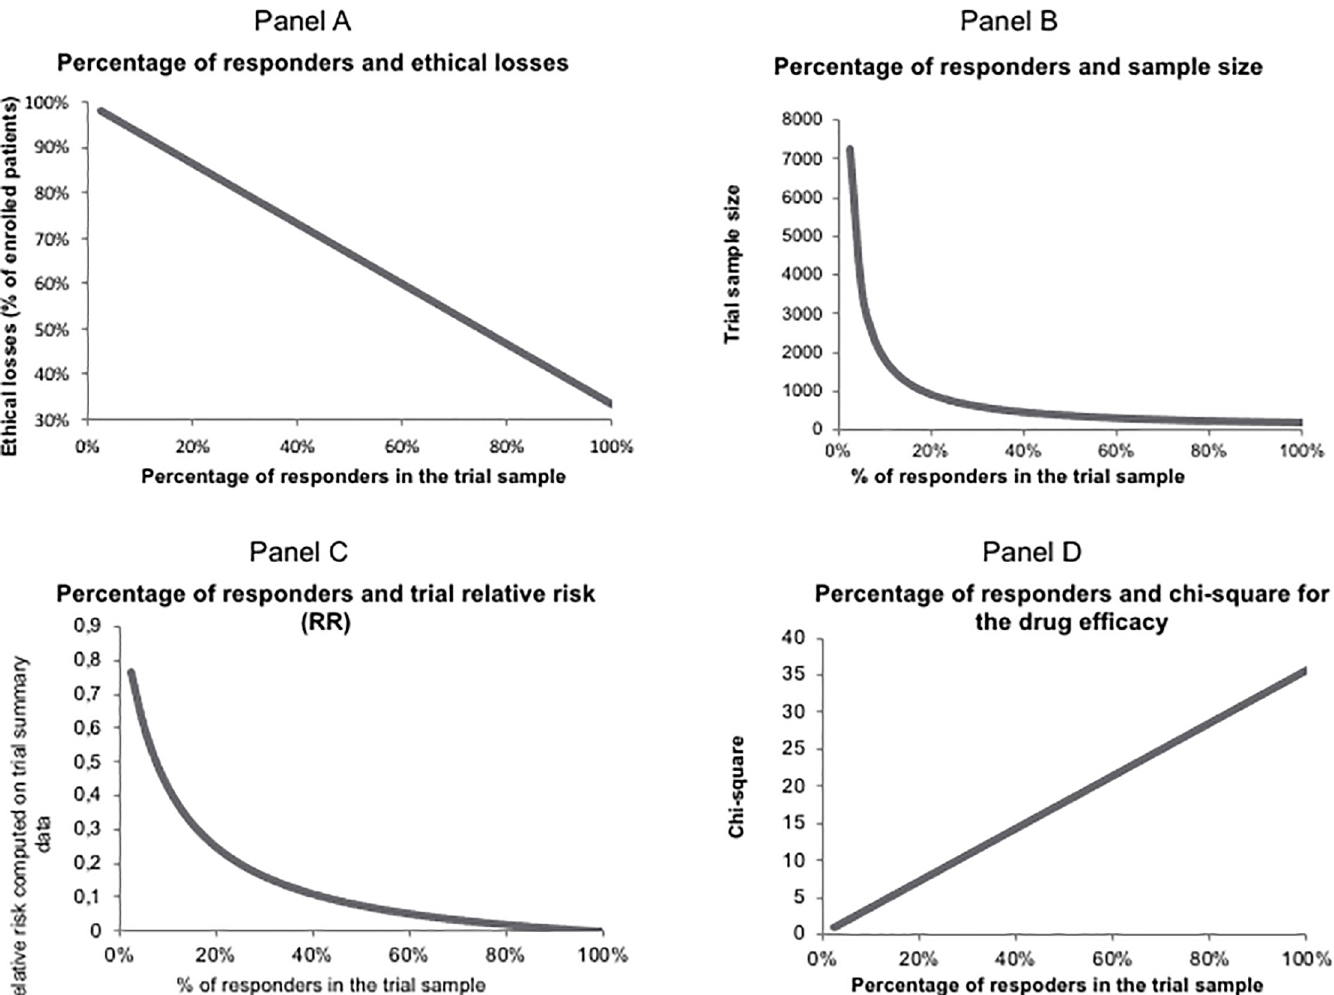
Fig 1. Relations between the proportion of responders in the trial sample and major features of the trial. Panel A, shows the linear decrease of the ethical losses expressed in percentage of unnecessary patients with the increase of the percentage of responders. Panel B, keeping the number of responders in the T group constant at n = 121, the sample size drops abruptly from more than 7,000 to less than 1,000 when the responder percentage increases up to about 20% to then flatten until the “perfect” trial status is reached, meaning that only responders are enrolled. Panel C, the relative risk decreases rapidly until the responder percentage reaches about 40%, from less than 0.8 to about 0. Panel D, the chi-square value of the comparison test of mortality rates between placebo and treatment groups increases linearly as the percentage of responders increases. The probability of ascertaining significance increases as well.